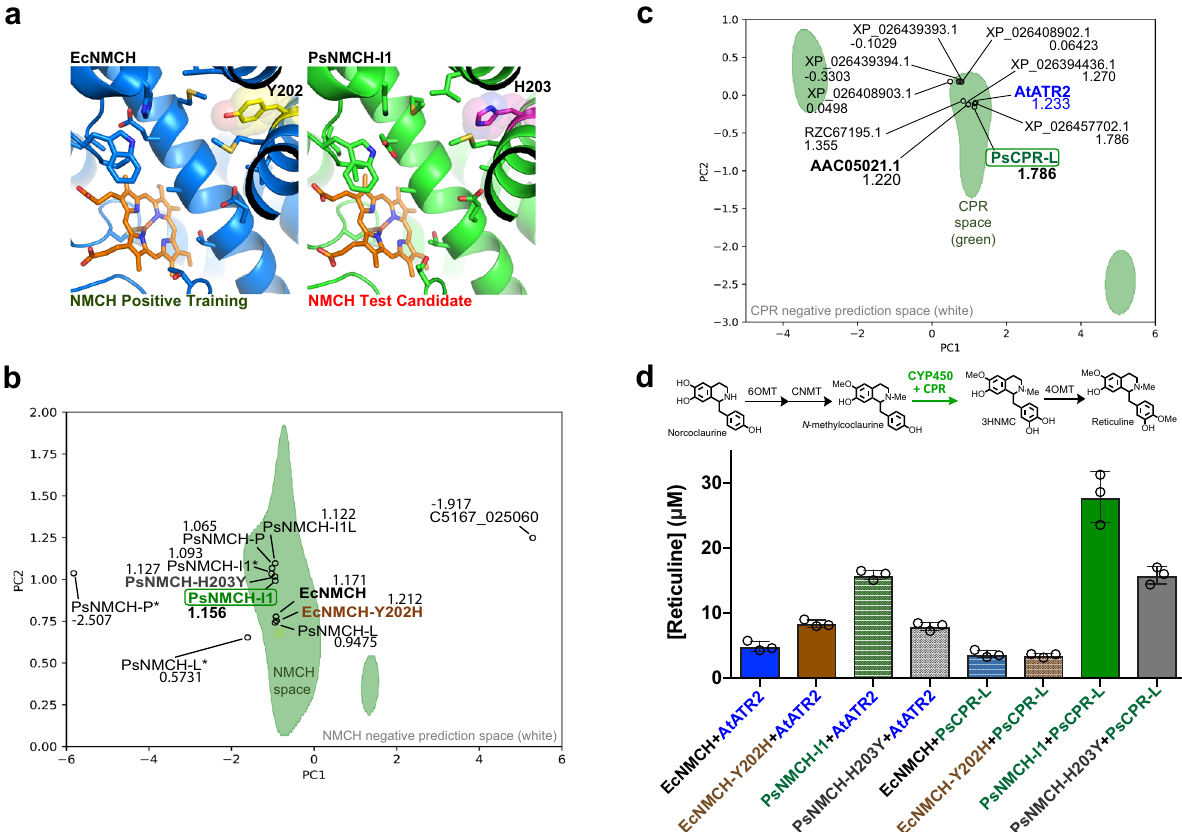
Fig. 5 Demonstration level prediction and tuning of P. somniferum NMCH and CPR for improved reticuline production from norcoclaurine. a Comparison of active site con fi gurations of positive training example EcNMCH (blue) with that of candidate sequence PsNMCH Isoform 1 (PsNMCH-I1, green). b For visual representation, two-dimensional SVM-based prediction of NMCH sequences is shown, with positive and negative prediction spaces colored green and white, respectively. Selected sequences are shown in bold. With exception to EcNMCH and EcNMCH-Y202H (brown), all points represent P. somniferum sequences. PCA is used to compress multi-dimensional data into two dimensions (PC1 and PC2) for the visual representation. Corresponding high-dimensional SVM results are detailed in Supplementary Table 4, and high-dimensional SVM decision scores are listed. c Two-dimensional SVM-based prediction of CPR sequences, with positive and negative prediction spaces colored green and white, respectively. With exception to positive training sequence AtATR2 (blue), all points represent tested P. somniferum sequences. PCA is used to compress multi-dimensional data into two dimensions (PC1 and PC2) for the visual representation. Corresponding high-dimensional SVM results are detailed in Supplementary Table 5, and high-dimensional SVM decision scores are listed. d Conversion of 1.2mM norcoclaurine to reticuline, mediated by various combinations of NMCH and CPR, together with Ps6OMT, PsCNMT and Ps4OMT, in strains N1-01-DE3, N1-02-DE3, N1-03-DE3, N1-04-DE3, N2-01-DE3, N2-02-DE3, N2-03-DE3, N2-04-DE3 (Supplementary Table 2). Here, individual samples were analyzed 3 times ( n = 3) to generate bar graphs in Prism 7 version 7.0d with error bars representing mean values + / − standard deviations. Source data are provided as a Source Data